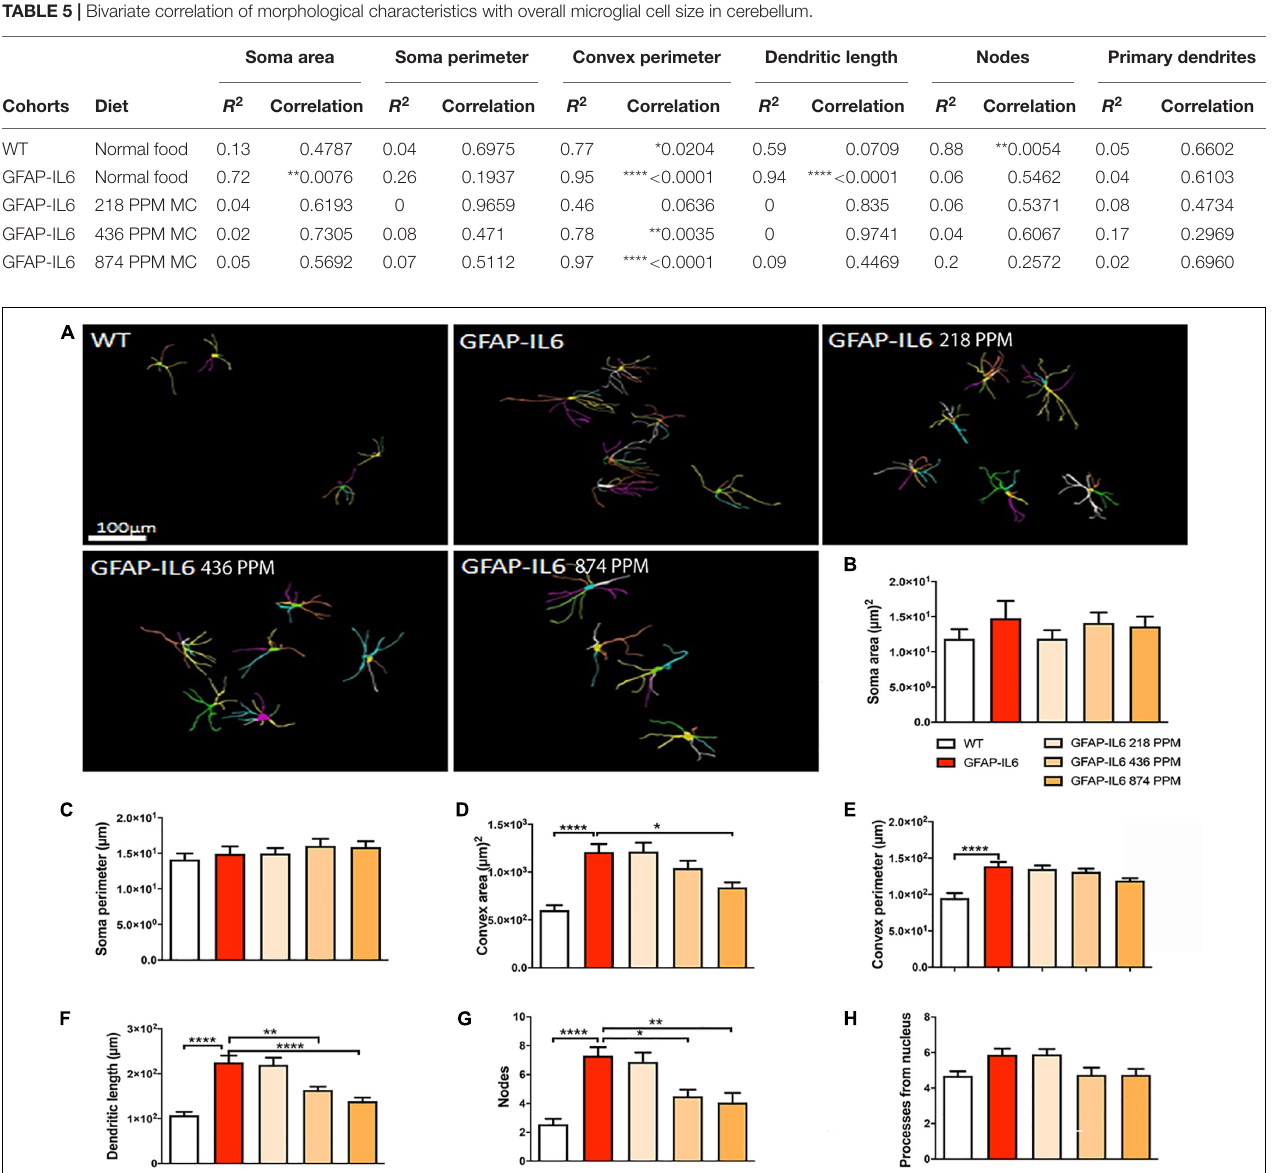
FIGURE 14 | Effect of MC on the morphological characteristics of astrocytes in the hippocampus. (A) 3D reconstruction of astrocytes in WT and GFAP-IL6 in both treated and non-treated mice. (B–H) Astrocytes in the inflamed mice have a significantly high convex area, convex perimeter, dendritic length and nodes compared with the WT. High dose MC significantly decreased the convex area, dendritic length, and nodes, whereas the medium dose also significantly decreased both the dendritic length and number of nodes compared with the GFAP-IL6. One-way ANOVA, Tukey’s post-test, Significance = * p < 0.05, ** p < 0.001, **** p < 0.0001 (mean ±